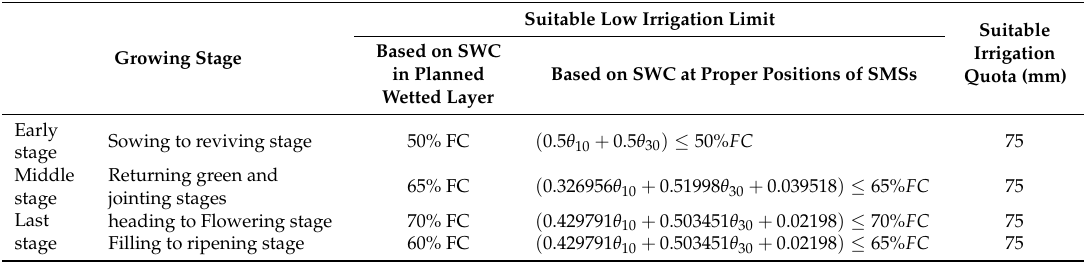
Suitable Irrigation Quota